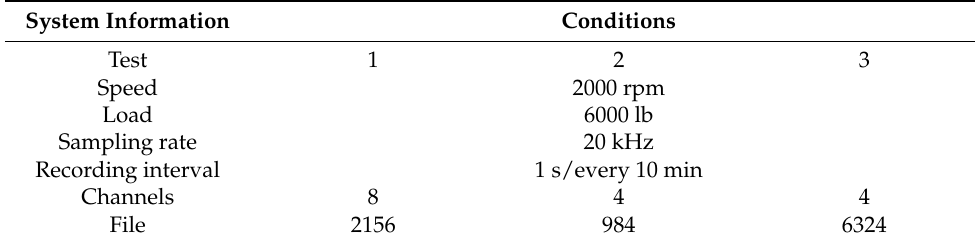
Table 1. Three test conditions for the IMS dataset.